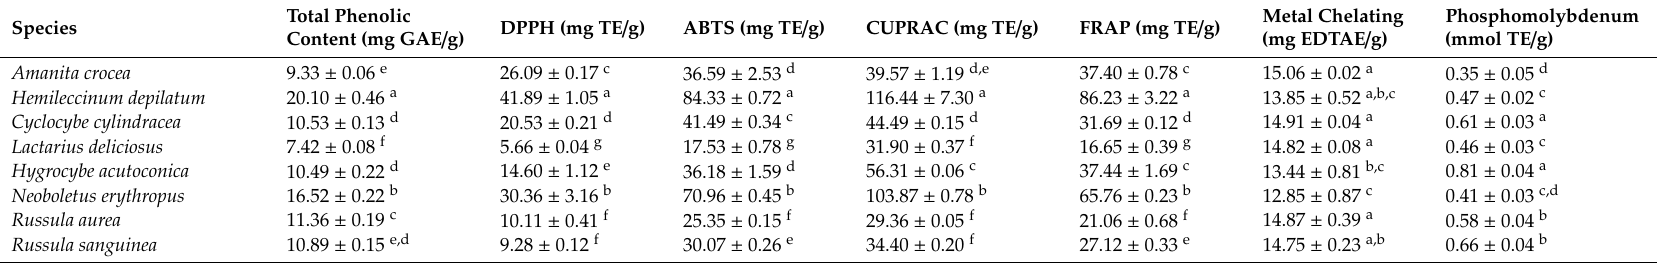
Table 2. Total phenolic content and antioxidant properties of the mushroom species *.